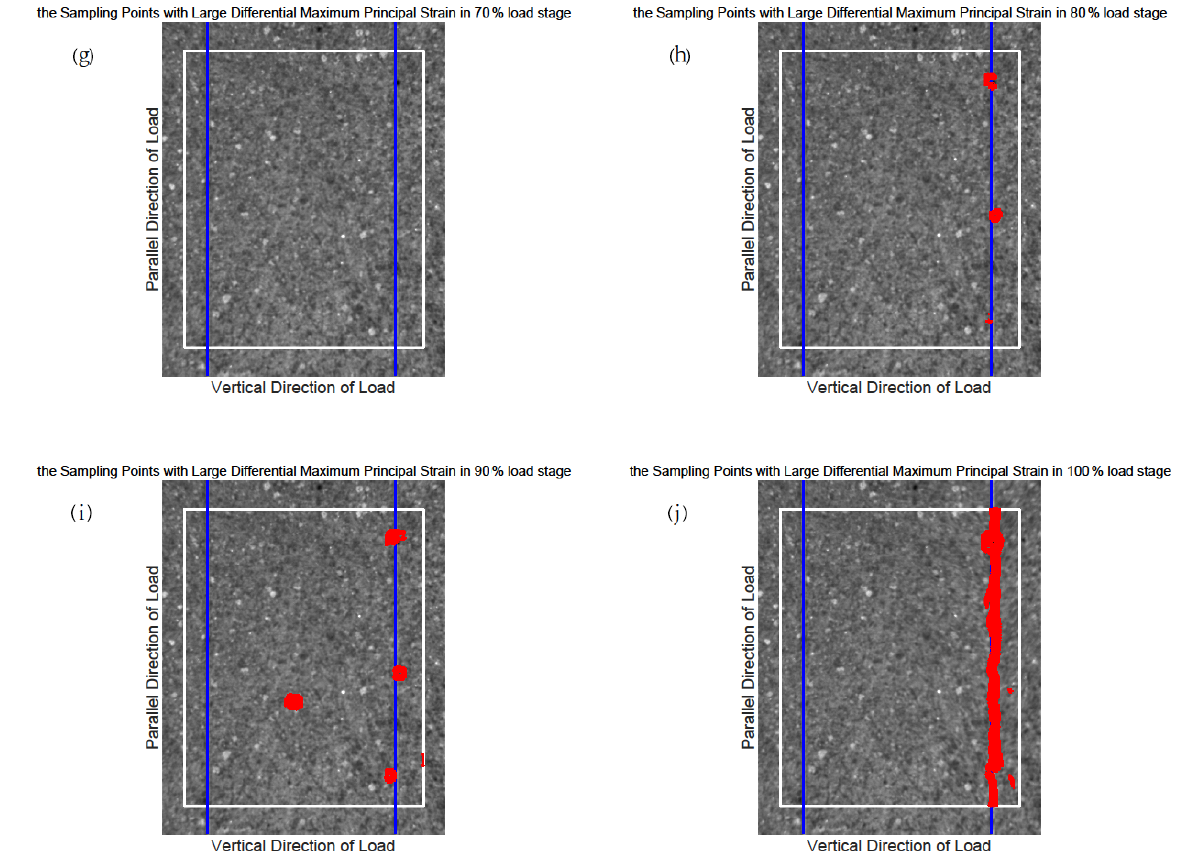
Figure B1. The position of the sampling points with large differential maximum principal strain for sample 1. The blue lines indicate the prefabricated cracks. Each figure shows the observational area of sample 4 in the experiments. The area enclosed by the white rectangle is the calculation domain, and its size is constant in different loading stages. The red points represent the sampling points with large differential maximum principal strain that satisfy the judgment condition as the load increases (from a to j